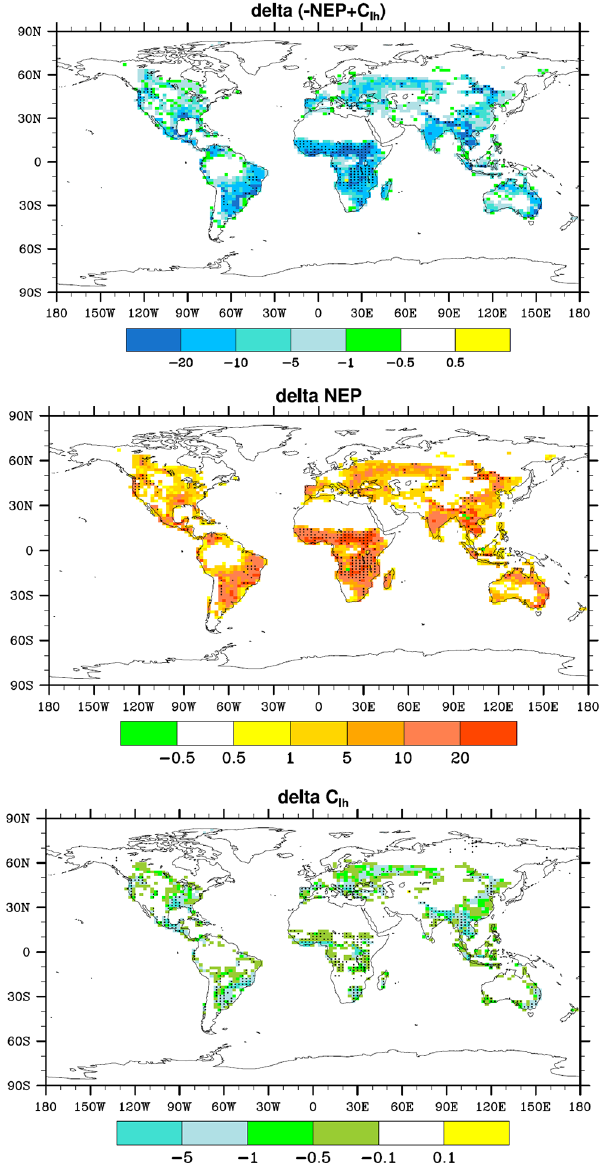
Fig. 6. Difference (fire-on minus fire-off) in the average of an- nual − NEP + C lh , NEP, and C lh for 1900–1999. The difference for − NEP + C lh represents the fire indirect effect. Difference in aver- age with the student’s t test at α = 0.05 significance level is stippled. Unit is g Cm − 2 yr − 1